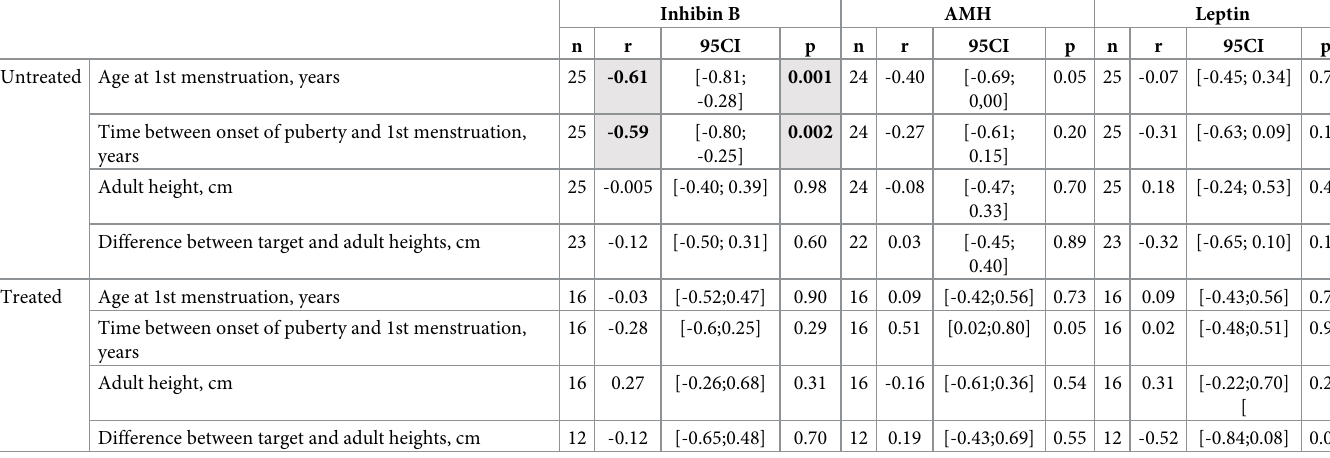
BMI: body mass index; LH: luteinizing hormone, FSH: follicle stimulating hormone, AMH: anti-Mu¨llerian hormone, 95CI: 95% confidence interval